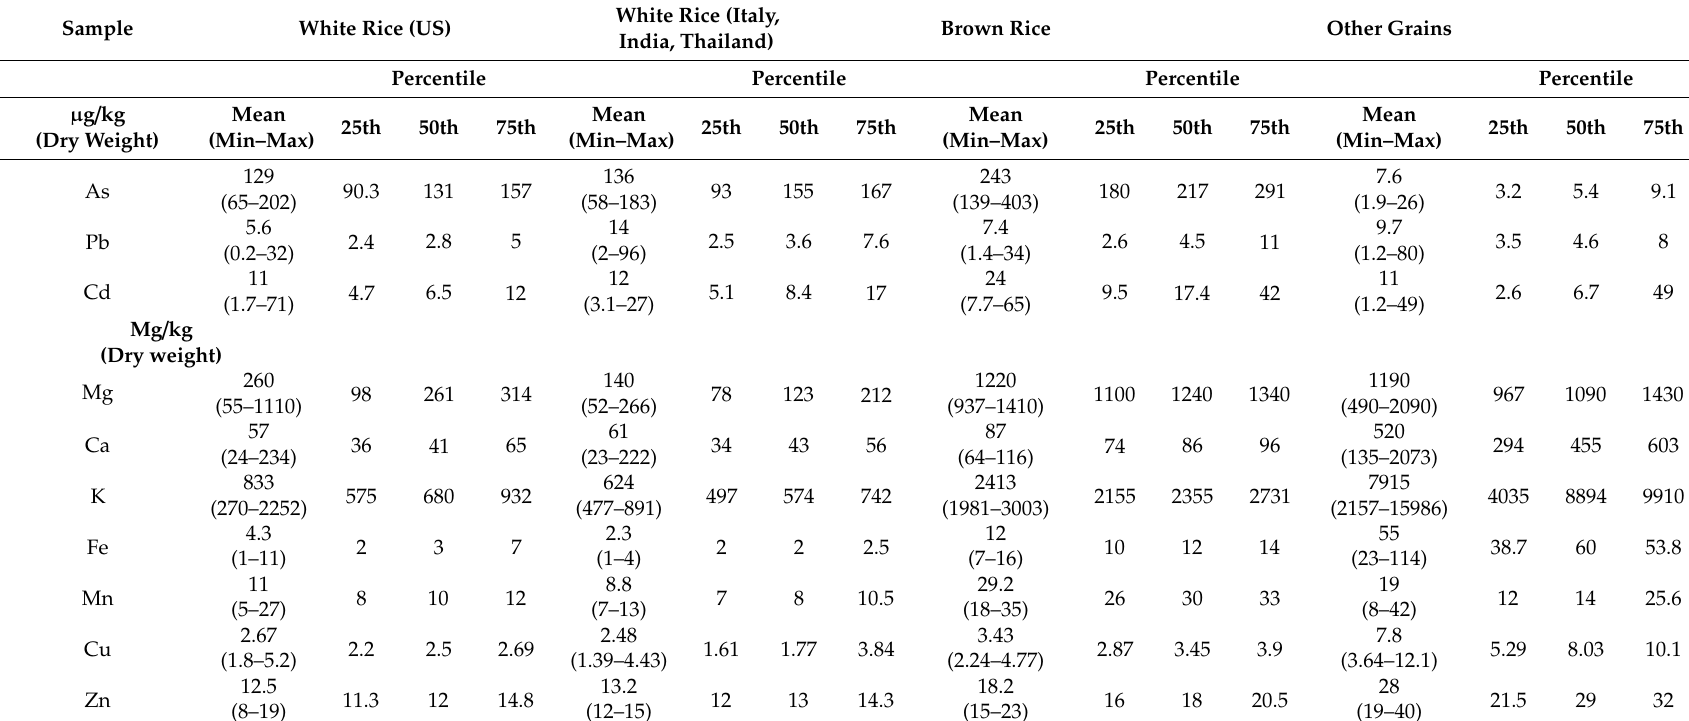
Table 1. Toxic and essential elements concentrations in rice and other